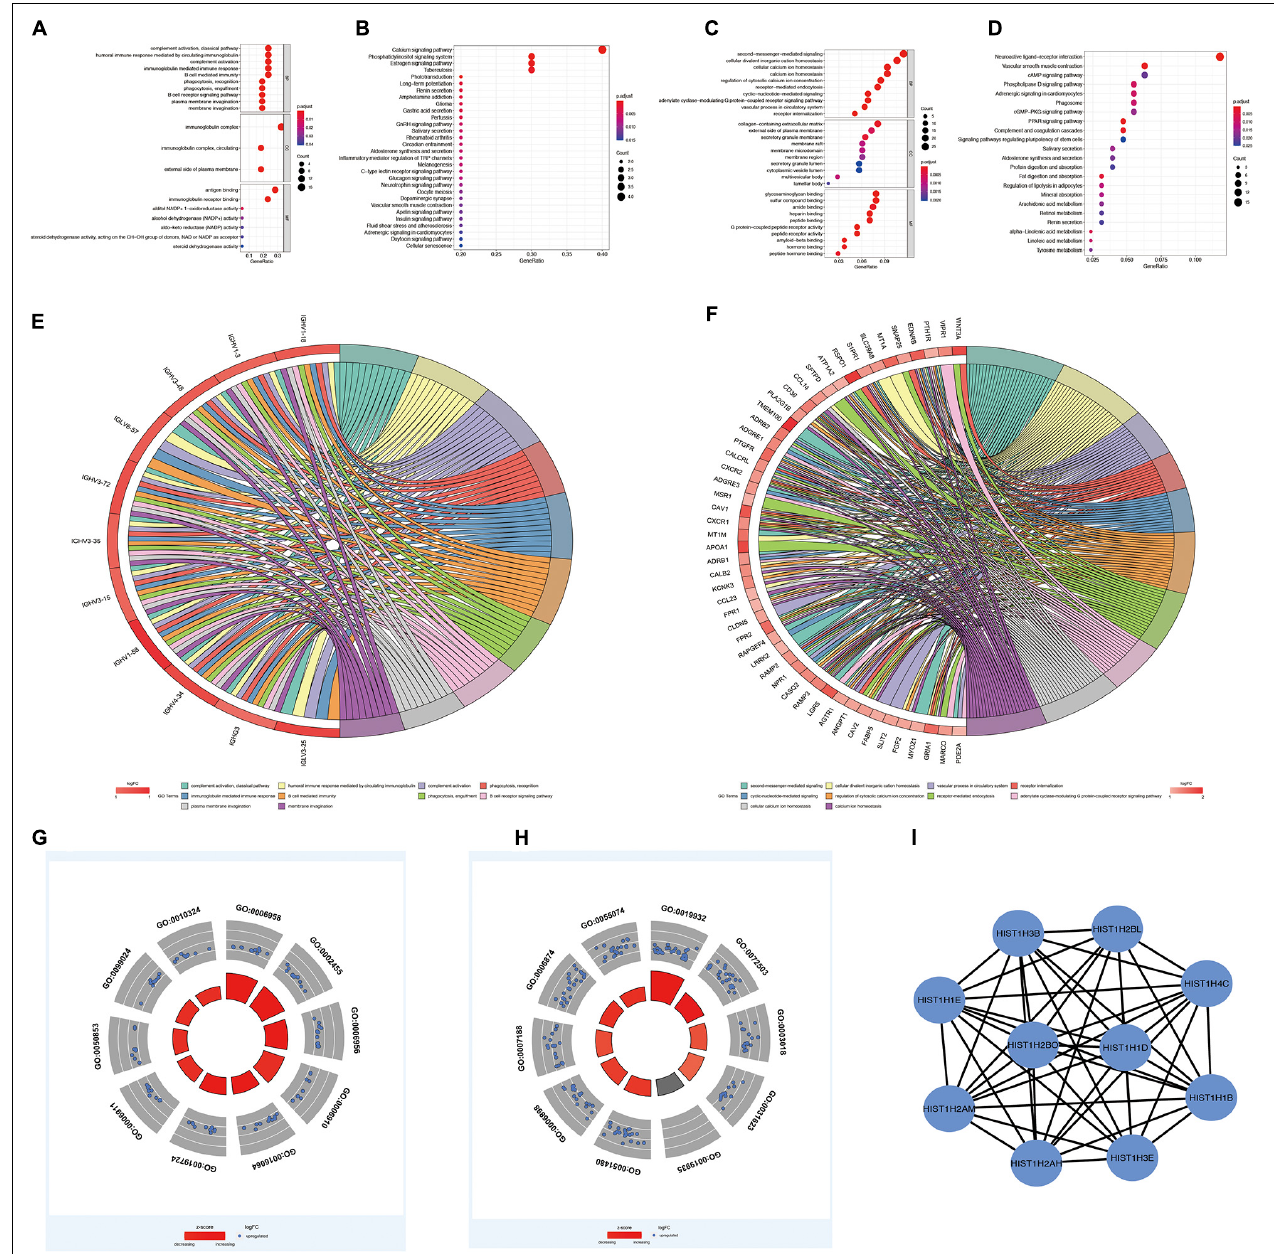
FIGURE 7 | Functional enrichment analysis of DEGs in LUAD. (A,C) GO terms of DEGs in cluster 1 and cluster 2. (B,D) KEGG pathways enriched for the DEGs in cluster 1 and cluster 2. (E,F) The correlation between statistically top 10 DEGs and their GO terms in cluster 1 and cluster 2. (G,H) Functional analysis of the genes with higher expression using GO terms in cluster 1 and cluster 2. The outer circle means the expression (logFC) of DEGs in each enriched GO terms: Blue dots indicated the upregulated DEGs. The inner circle means the significance of GO terms (log10-adjusted p values). All p < 0.05 was considered to be statistically significant. (I) Hub genes selected via cytoHubba. GO, Gene Ontology; DEGs, differentially expressed genes; LUAD, lung adenocarcinoma; KEGG, Kyoto Encyclopedia of Genes and